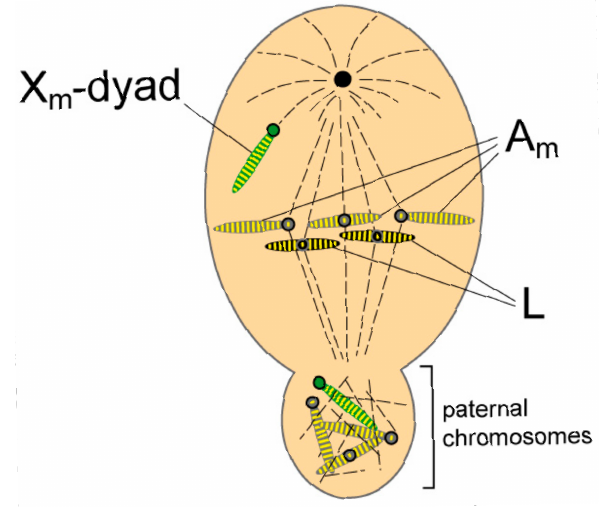
Figure 4. Lack of phosphorylation of the X centromere region at meiotic metaphase II. The Xm-dyad is seen precociously at the monopole. The arms of Xm retain histone histone 3 (H3) phosphorylation (given as yellow stripes), while the centromere region (the ribosomal DNA (rDNA)-chromosomal tip) is devoid of phosphorylation (no stripe in the X centromere). The regular maternal homologues and the L chromosomes lie on the metaphase plate and exhibit phosphorylation of histone H3 both along the arms and the centromere regions. The regular paternal chromosomes found in the bud are also phosphorylated except for the centromere region of Xp. Circles indicate centromere position on the chromosomes. The L chromosomes are black, the autosomes are grey and the X chromosomes are green. Phosphorylation is shown as yellow